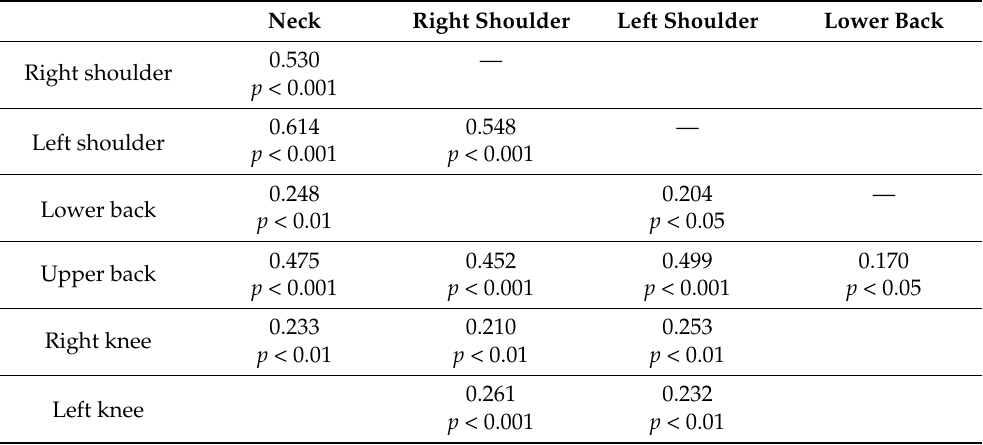
Table 6. Correlations among body parts in which discomfort was